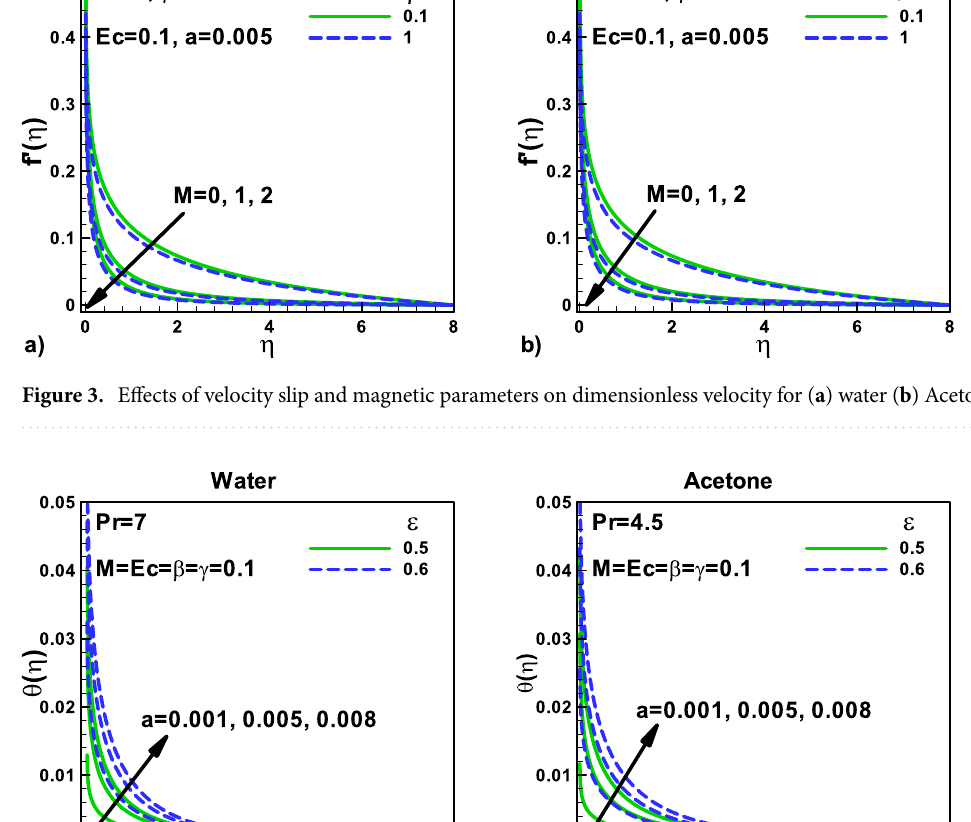
and acetone are decreased due to an increase in the applied magnetic effect. The thermal slip parameter, velocity ratio parameter, and needle size are kept the same for both water and acetone. In Fig. 4, the velocity ratio parameter’s effects on the dimensionless temperature at different positions for (a) water and (b) Acetone are shown , respectively. In both cases, the dimensionless temperature increase with the increase in the needle size. The magnetic effect, velocity slip, and thermal slip parameters are kept constant. When the tinny needle moves with the free stream velocity, the thermal resistance is higher, and as a result, the heat transfer rate is lower. The thermal slip parameter γ helps in increasing the dimensionless temperature inside the thermal boundary layer in both cases. Figure 5: The effects of velocity slip and magnetic parameters on dimensionless temperature for (a) water and (b) acetone are shown, respectively. In both cases, the dimensionless temperature increases with the increase of magnetic parameters for different velocity slip parameters. When the tinny needle moves with the free stream velocity, the thermal resistance is higher, and as a result, the heat transfer rate is lower. The thermal slip parameter γ helps increase the dimensionless temperature inside the thermal boundary layer in both cases. The comparison shows the higher surface temperature for water under the same conditions. Due to the lower Prandtl number Pr , the thermal boundary layer thickness for water is higher than acetone. Figure 6: Variation of skin friction with magnetic field and velocity ratio parameter at different positions for 0.5 and ε 0.8 are shown. Note for the Skin friction (a) water and (b) Acetone. The velocity ratio parameter ε = = C f , that it is independent for thermal slip parameter γ and the fluid properties because there is no change for the different Pr and same velocity slip and thermal slip parameter. As the velocity ratio parameter ε increases, the skin friction C f increase due to increase in the free stream velocity and increase in magnetic effect. Figure 7: Variation of Nusselt number with magnetic field and velocity ratio parameter at different positions for (a) water and (b) Acetone , respectively. The three different needle sizes are selected to investigate these effects. As expected, the Nusselt number Nu have a direct relationship with the needle size as needle size increase it will enhance the Nusselt number Nu due to an increase in surface area in both cases. The thermal slip parameter γ increases with the temperature gradient, and as a result, the Nusselt number Nu increases. The Prandtl number Pr